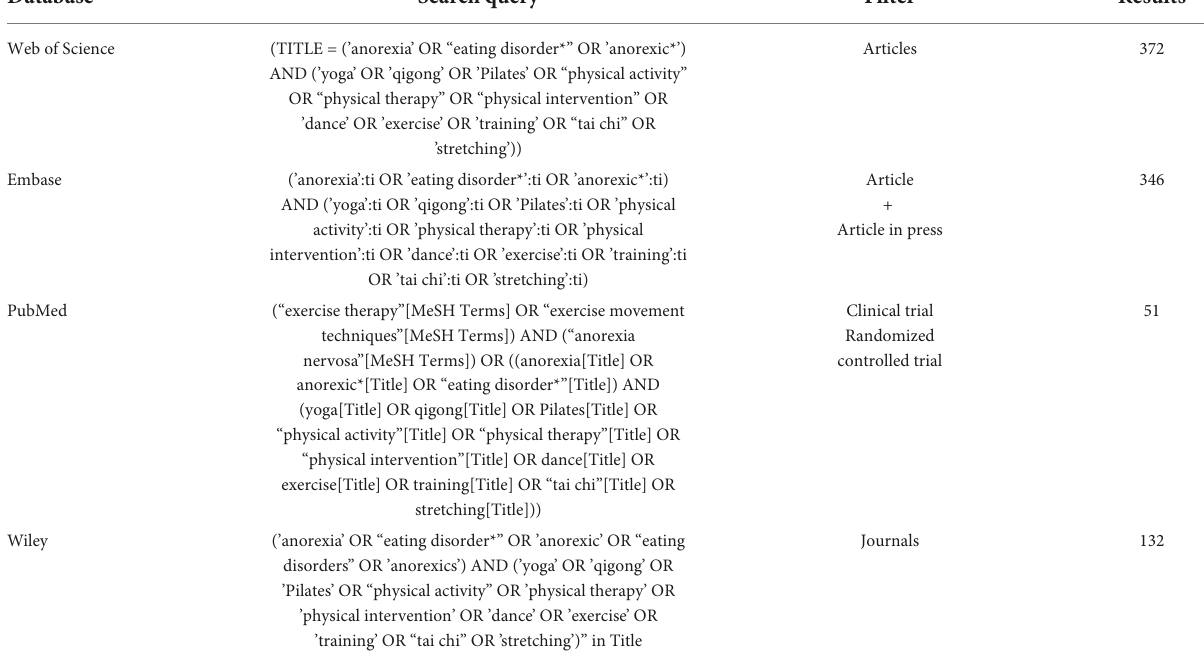
TABLE 2 Databases search queries from inception to December 31